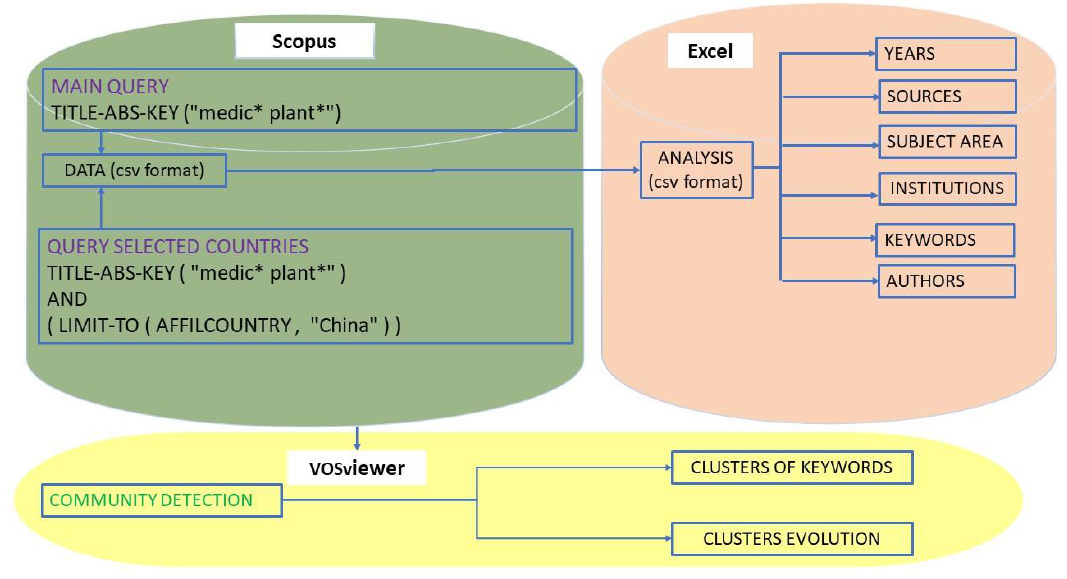
Figure 1. Methodology.